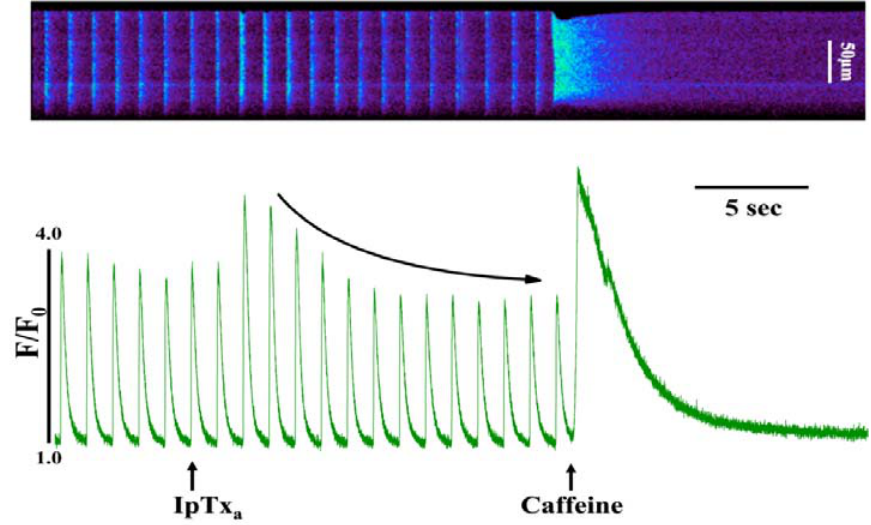
Figure 2. Perfusing intact cardiomyocytes with 100 nM IpTxa produced an increase in the transient followed by a gradual decrease to a new steady-state . amplitude of the [Ca 2+ ] i Line-scan image (top) and associated fluorescence plot (bottom) of a field-stimulated mouse ventricular cardiomyocyte loaded with the Ca 2+ indicator Fluo-4 and perfused constantly with normal Tyrodes solution in the absence of IpTxa. At the time indicated by the arrow, IpTxa (100 nM) or caffeine (10 mM) was perfused onto the cell. The protocol was repeated 36 times and the result below is representative of 12